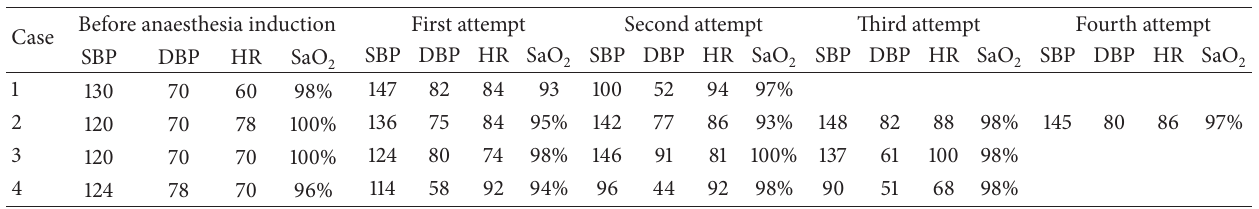
Table 2: Hemodynamic parameters and saturation in oxygen during endotracheal intubation attempts. Before anaesthesia induction Case